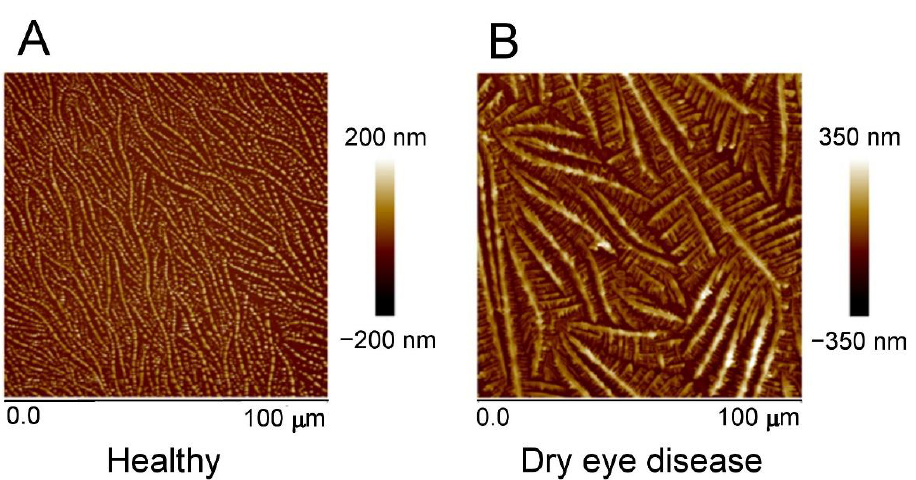
Figure 2. Tear film crystals after dehydration in the group of ( A ) healthy subjects and ( B ) dry eye disease subjects.